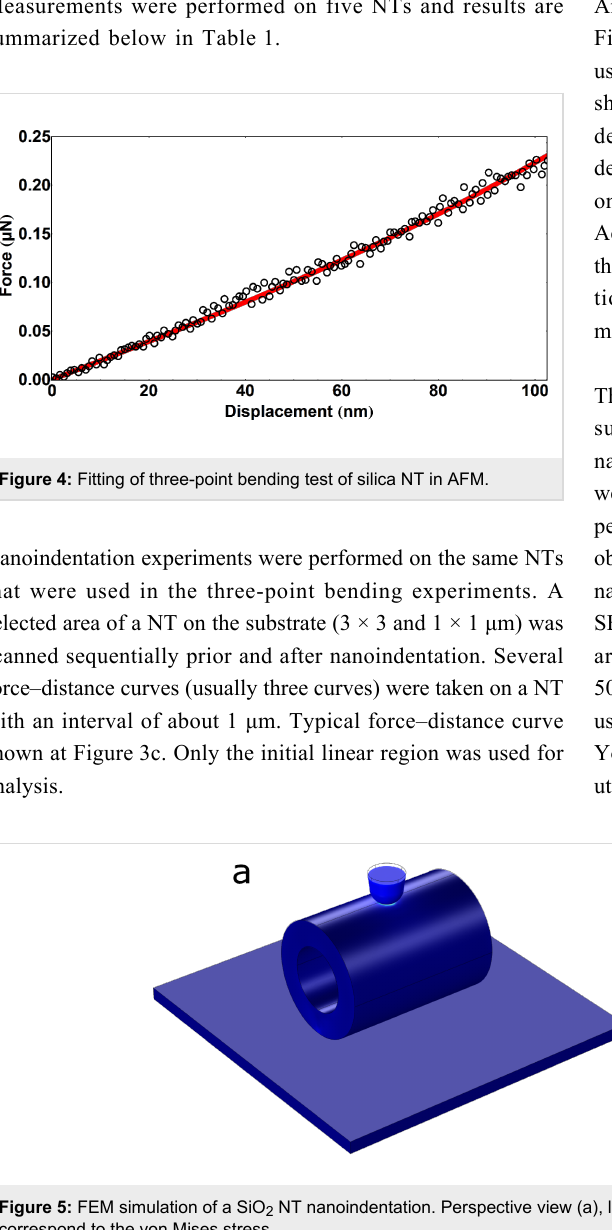
force spectroscopy a NT was scanned sequentially at a higher magnification (typically 3 × 3 and 1 × 1 μ m). Several force–dis- tance curves were taken in the center of a suspended NT. The curves were linear, and the loading and unloading curves coin- cide, which indicates an elastic response of the NT. A force–distance curve taken on a hard oxidized silicon substrate is shown for comparison (Figure 3b). Values of Young’s modulus were calculated by using Equation 3 and Equation 4. Fitting results are shown in Figure 4. The initial region, i.e., the region of displacement below the characteristic inner radius of NT, was used for fitting since the high load region would be invalid due to non-linearity and plastic deformation effect. Measurements were performed on five NTs and results are summarized below in Table 1.